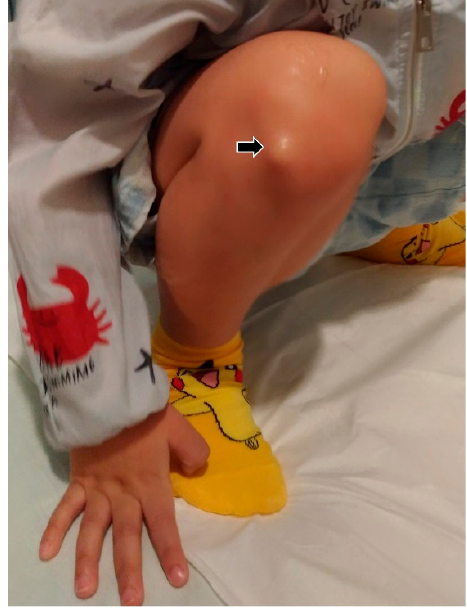
Figure 2. A mass (black arrow) was seen protruding from the lateral infrapatellar region when squatting.